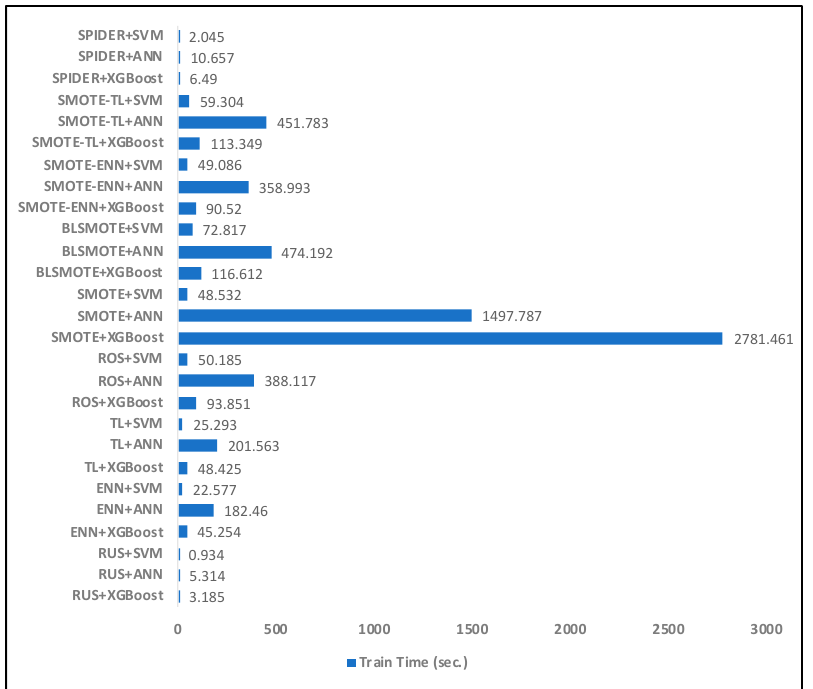
Figure 10. Training time (s) for all the fusion models.